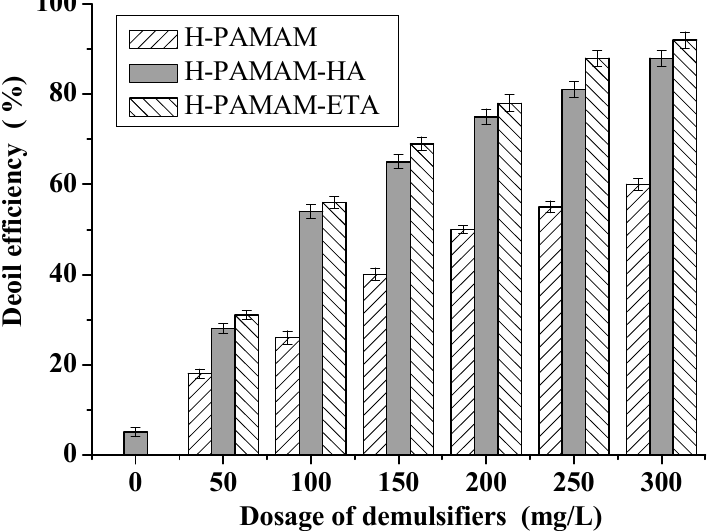
ff erent dosages at 30 ◦ C for 30